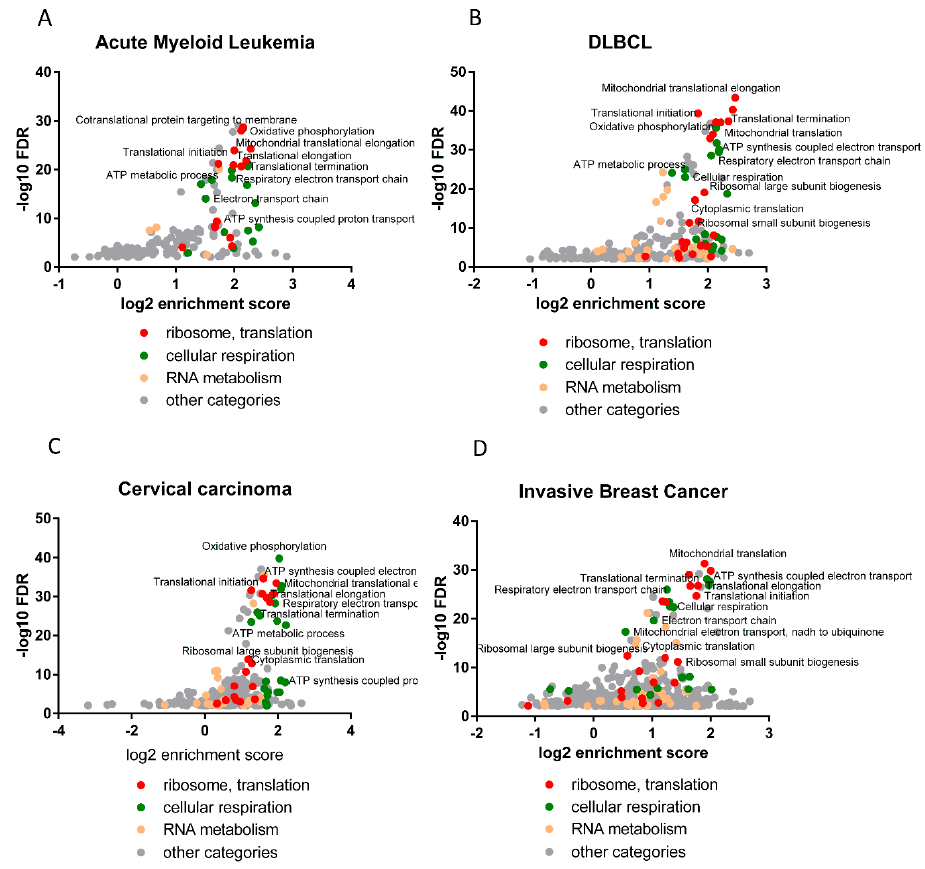
Figure 6. The subset of genes whose expression correlates with HAX1 in the four different neoplasms exhibits enrichment in the same biological processes as shown for HAX1 KO. Correlation analysis was performed using cBioPortal Cancer Genomics. Clinical data obtained from the TCGA